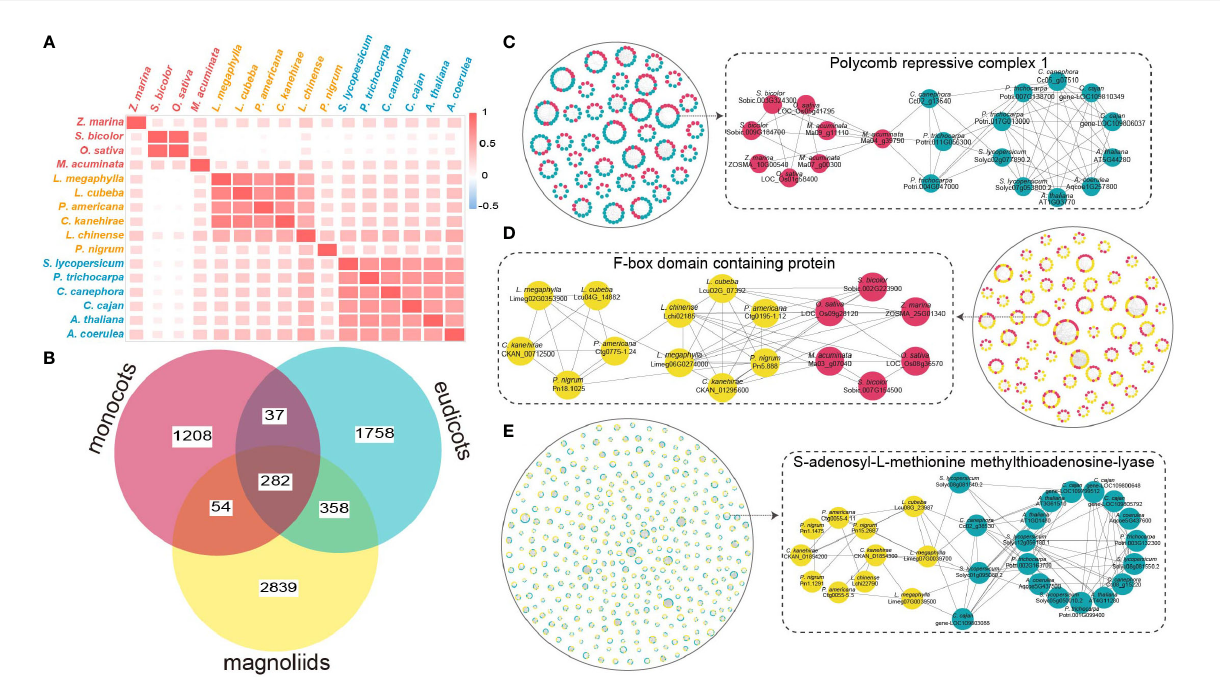
FIGURE 2 Analysis of gene microsyntenic clusters. (A) Heatmap of the number of microsyntenic clusters shared among Magnoliid, eudicot, and monocot species. (B) Venn diagram showing the microsyntenic clusters shared among Magnoliids, eudicots, and monocots. (C) The black solid circle on the left surrounds microsyntenic clusters shared by eudicots and monocots, where blue dots represent eudicots, and red dots represent monocots. The black dotted rectangle on the right highlights an example of a cluster (in a subnetwork) shared between eudicots and monocots. (D) The black solid circle on the right surrounds microsyntenic clusters shared by Magnoliids and monocots, where yellow dots represent Magnoliids and red dots represent monocots. The black dotted rectangle on the left highlights an example of a cluster (in a subnetwork) shared between Magnoliids and monocots. (E) The black solid circle on the left surrounds microsyntenic clusters shared by Magnoliids and eudicots, where yellow dots represent Magnoliids and blue dots represent eudicots. The black dotted rectangle on the right highlights an example of a cluster (in a subnetwork) shared between Magnoliids and